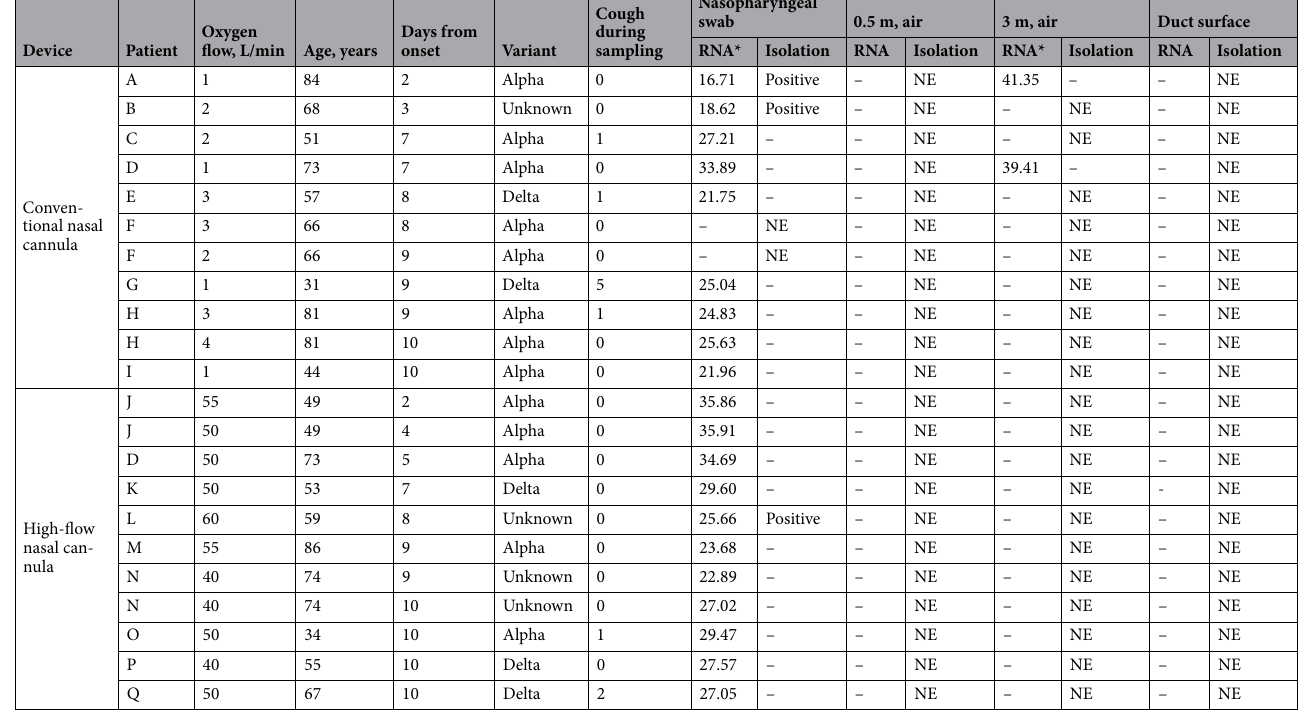
Table 2. Details of each sample and the results of viral detection. *The cycle threshold value is presented for RNA detection. NE Not